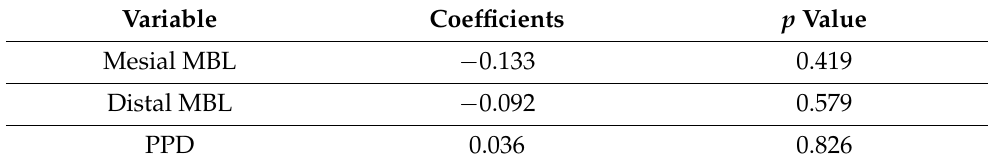
Table 2. Univariate statistical analysis regarding MBL and PPD at 6 months follow-up